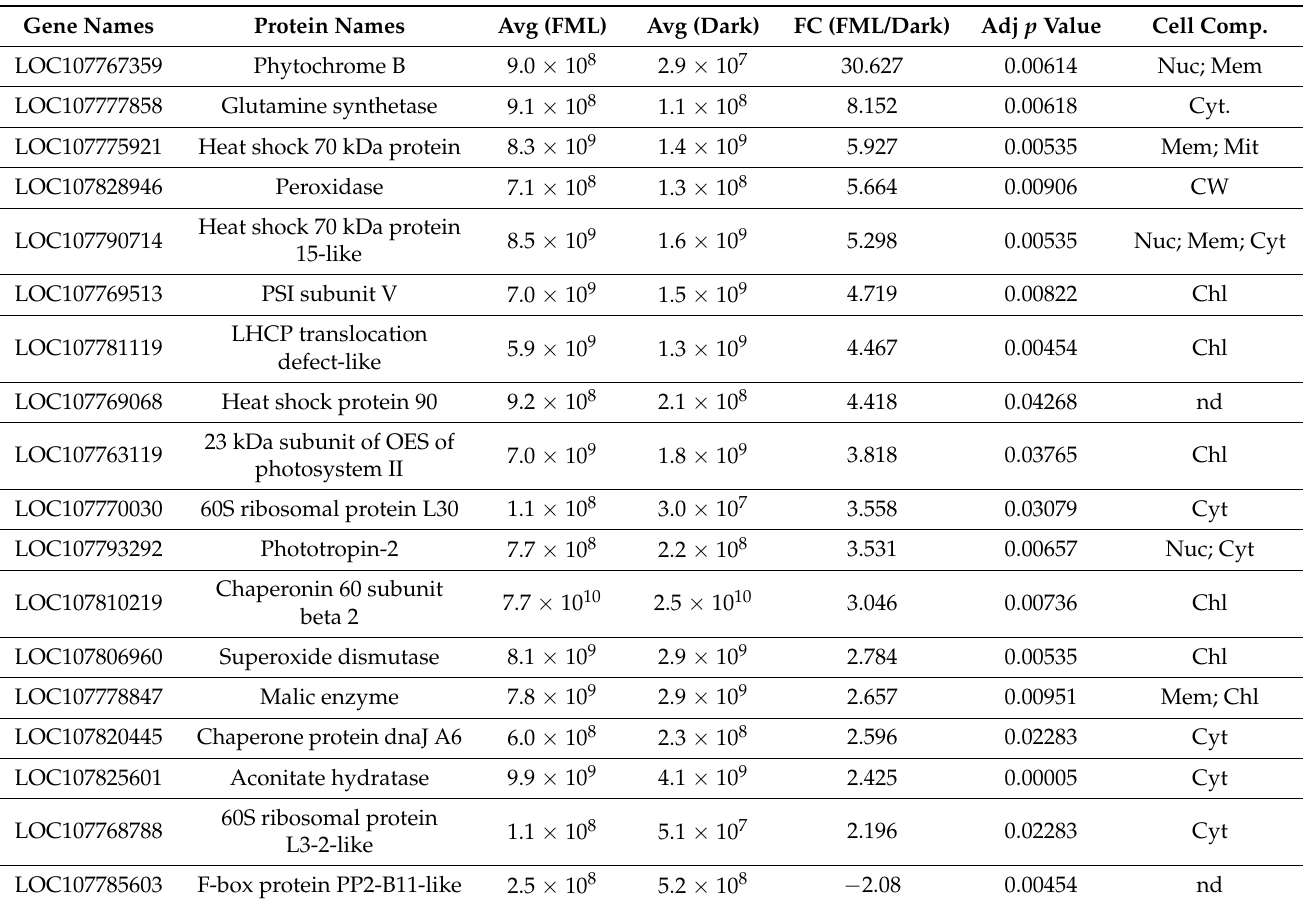
Table 2. A partial list of proteins up- and downregulated under FML compared to the dark. FC, fold change (>2; p < 0.05). Chl, chloroplast; CW, cell wall; Cyt, cytoplasm; Mit, mitochondria; Mem, membrane; nd, not defined; Nuc,